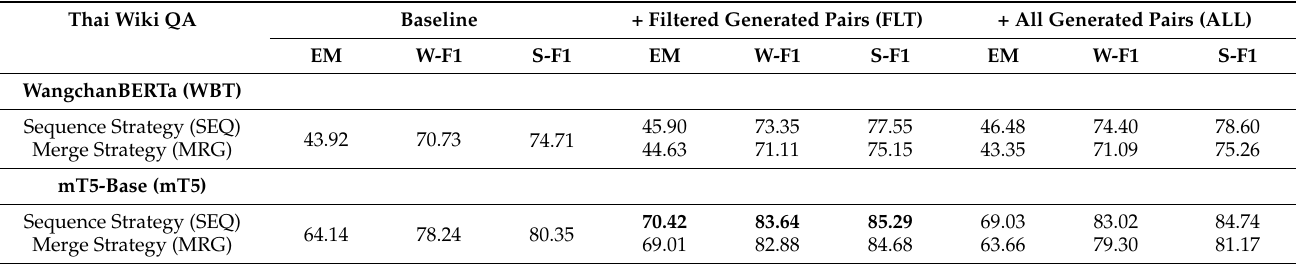
Table 4. The experiment result of our method compared to baseline models of Thai Wiki QA. (EM, W-F1, and S-F1 refer to Exact Match, word-level F1 and syllable-level F1 respectively. Boldface refers to the winner.).